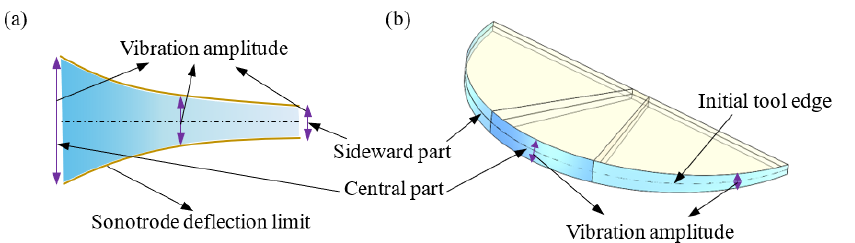
Figure 12. Schematic diagram of ( a ) the sonotrode deflection and ( b ) tool vibration amplitude distribution along the tool edge in the bending vibration mode.